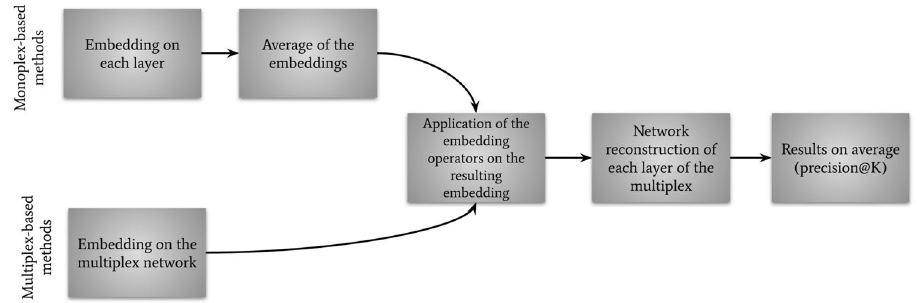
Figure 4. General approach for network reconstruction on multiplex networks: (top) for monoplex-based methods, embed each layer with the given method, then average it; (bottom) for multiplex-based methods, apply the specific embedding method to the network. Embedding operators are then applied to monoplex- and multiplex-based method embeddings. The three types of methods are finally evalutated for network embedding using a binary classifier and a precision@K score is